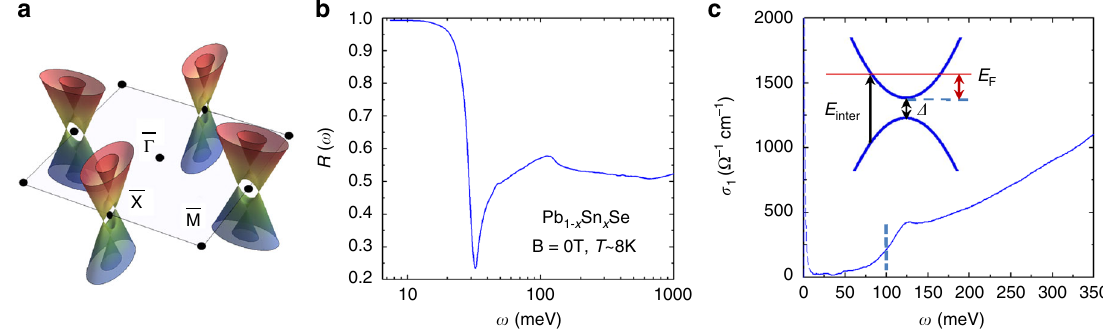
Fig. 1 IR spectra of Pb 1 − x Sn x Se ( x = 0.23 – 0.25) in zero magnetic fi eld. a Schematic band structure of the SS and the surface Brillouin zone. b IR re fl ectance spectrum R ( ω ) at T = 8 K. c The real part of the optical conductivity σ 1 ( ω ) at T = 8 K. The vertical dashed line around 100 meV indicates E inter . The inset shows a schematic of the band structure of the bulk states and the onset of inter-band transitions at E